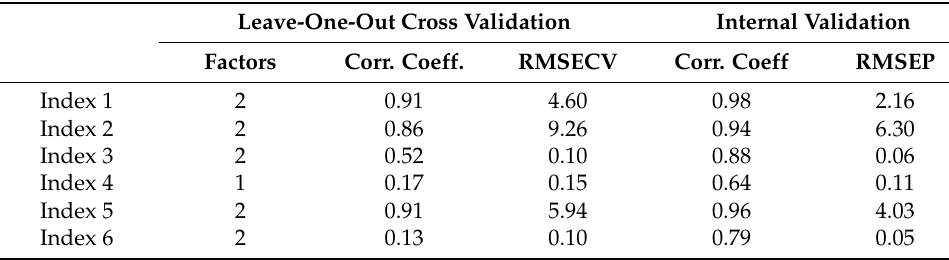
Table 4. Statistics for each stabilization index in PLSR cross- and internal